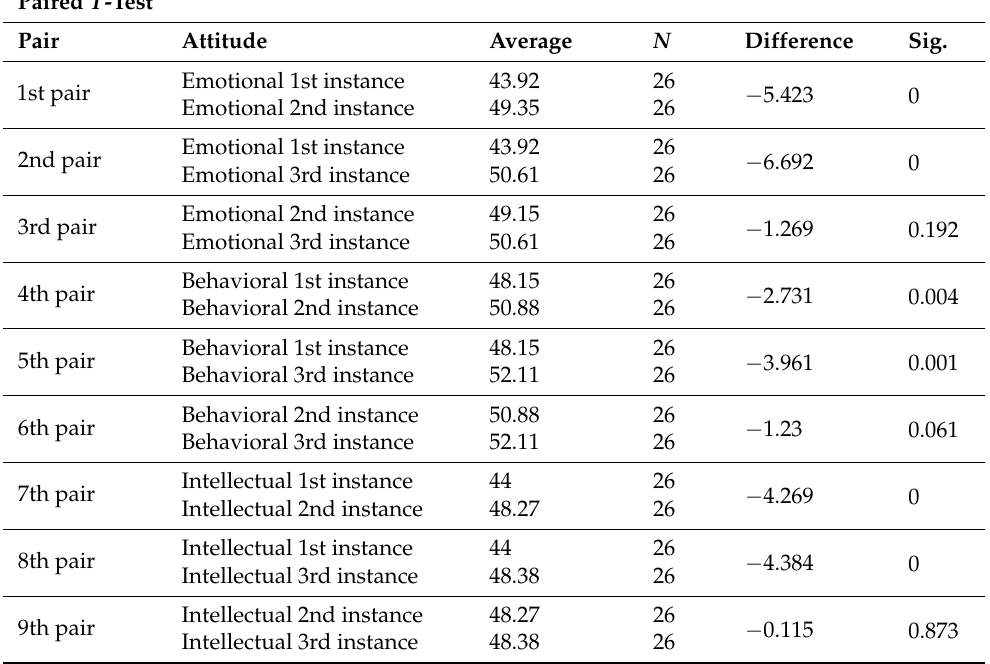
Table 2. Comparison averages from the different instances of the survey by instance.